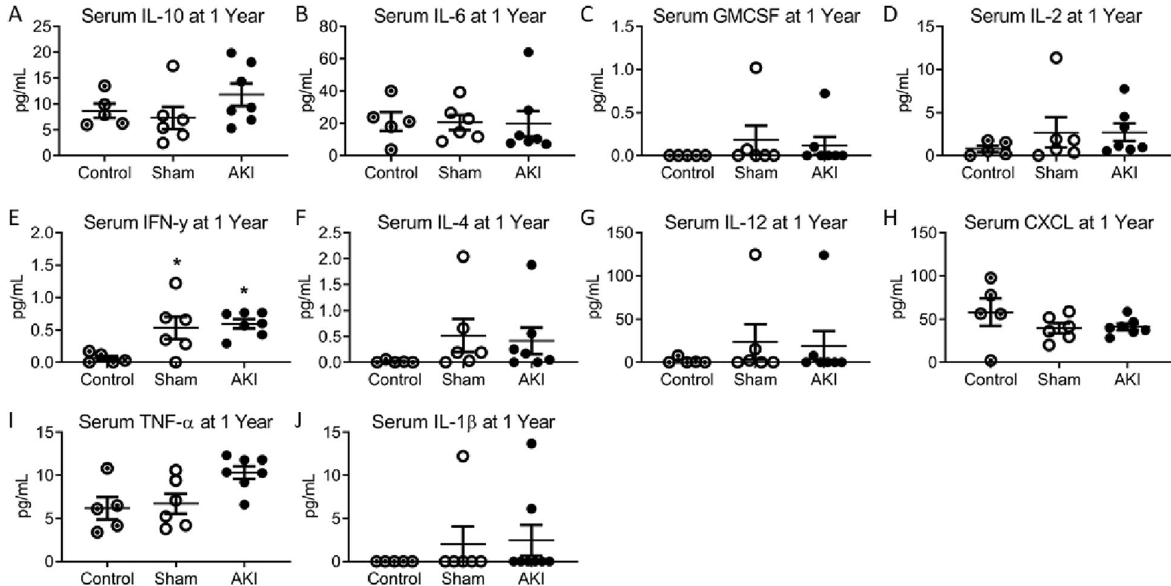
Figure 8. Serum cytokine profile in females 1 year after AKI. ( A ), IL-6 ( B ), GMCSF ( C ), IL-2 ( D ), IFN-γ ( E ), IL-4 ( F ), IL-12 ( G ), CXCL1 ( H ), TNF-α ( I ) and IL-1β ( J ). (n = 5–7) *Signifies P < 0.05 compared to